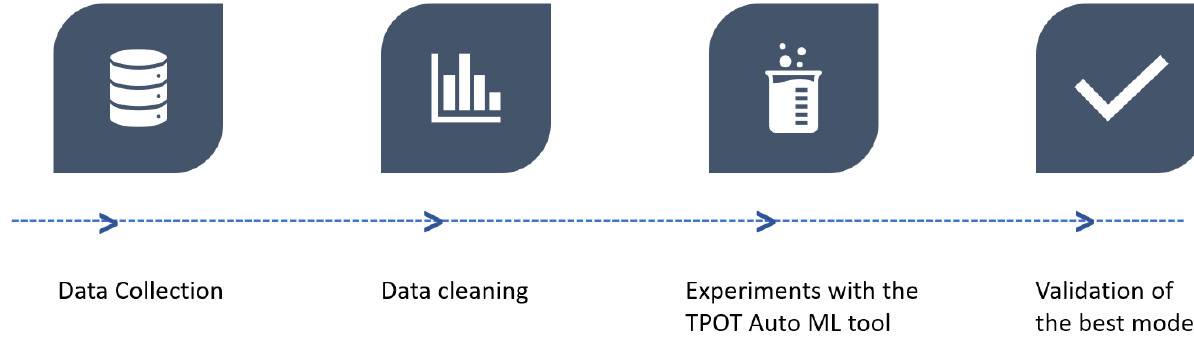
Figure 2. Flowchart of the